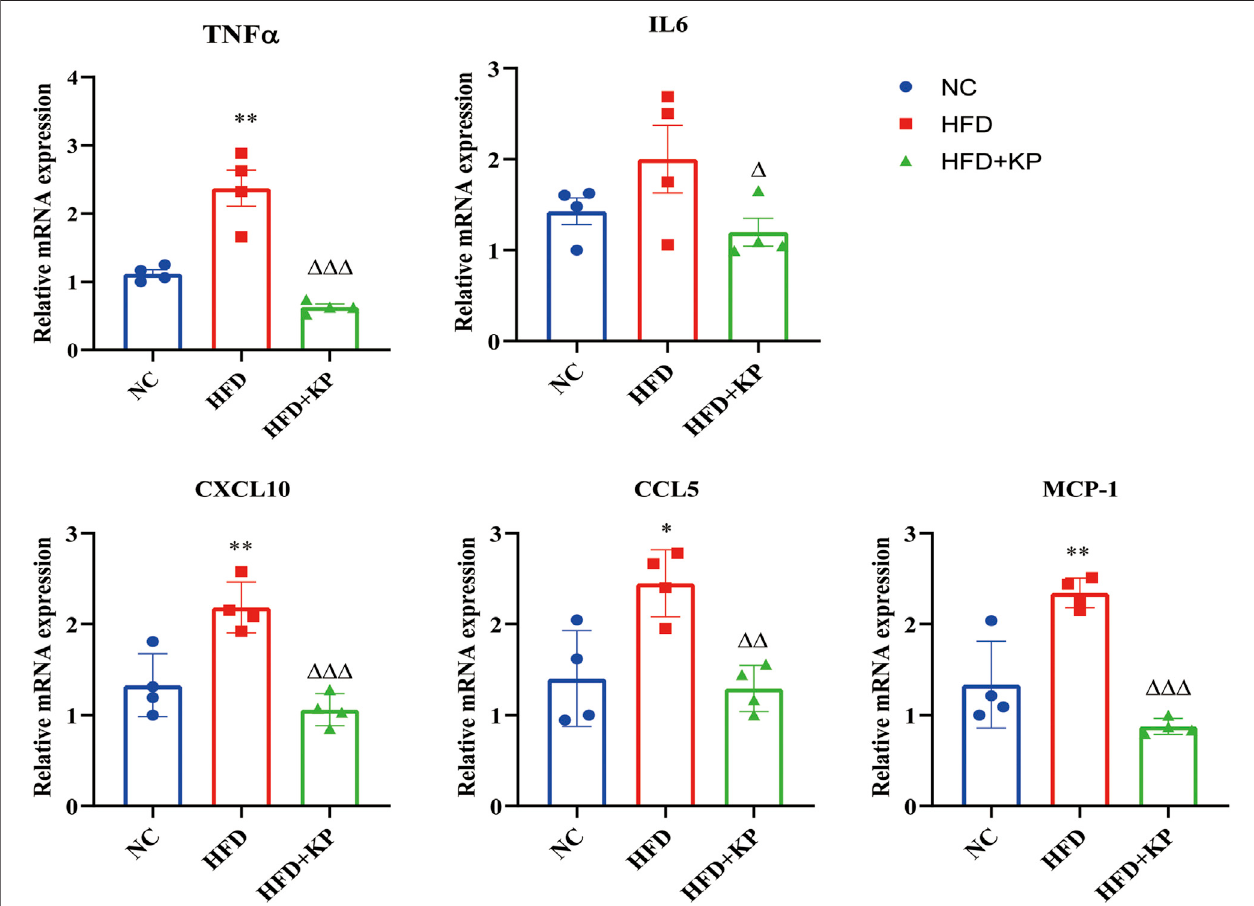
FIGURE 3 | KP reduced the mRNA expression of in fl ammatory factors in vivo . NC: Normal control group, HFD: HFD group, HFD + KP: HFD + KP group. Quanti fi cation of mRNA level expression was normalized to β -actin levels. Compared with group NC, *, p < 0.05, **, p < 0.01; Compared with group HFD, △ , p < 0.05, △△ , p < 0.01, △△△ , p <